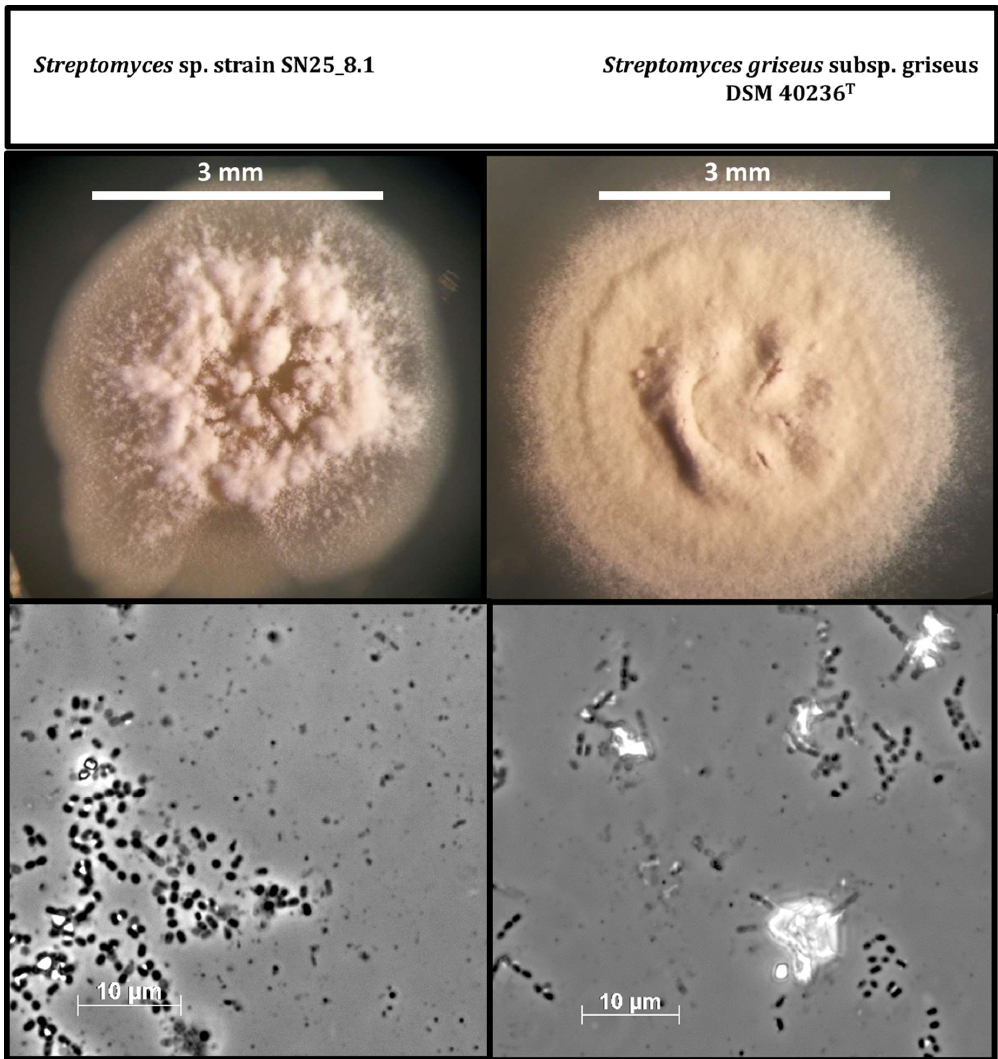
Figure 2. Comparison of cell and colony morphology of the two Streptomyces strains after growth on GYM medium for three weeks. Photos were recorded using a stereo microscope (upper figures) and microscope with a 100x lens (bottom figures).